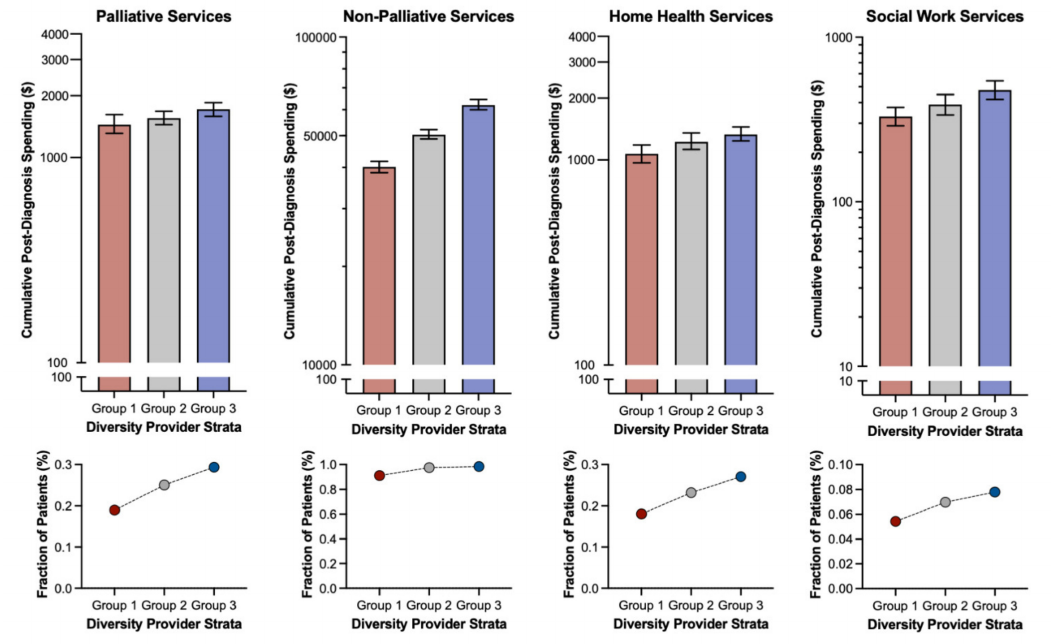
Figure 3. Effect of provider patient racial diversity index (provider pRDI) : effect of provider pRDI on spending for palliative, non-palliative, home health, and social work services in the matched